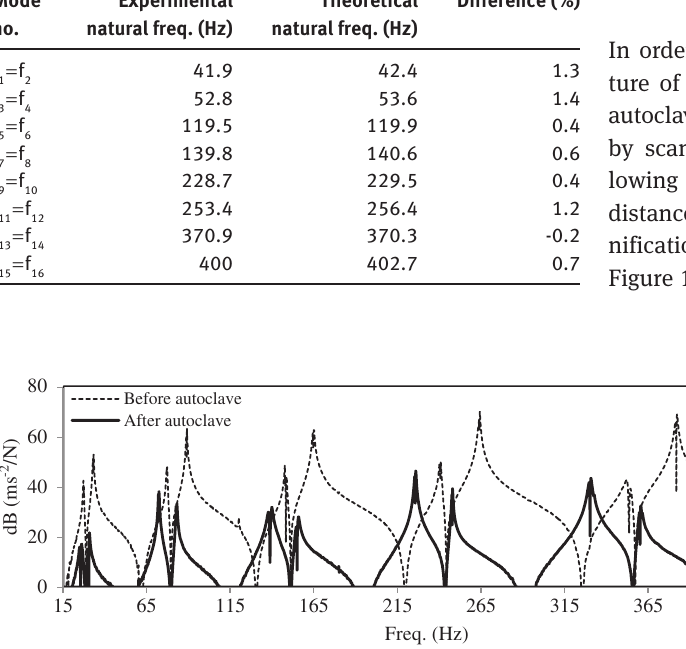
Figure 11: Comparison between FRF graphs for truncated cone # 1 before and after autoclave treatment.